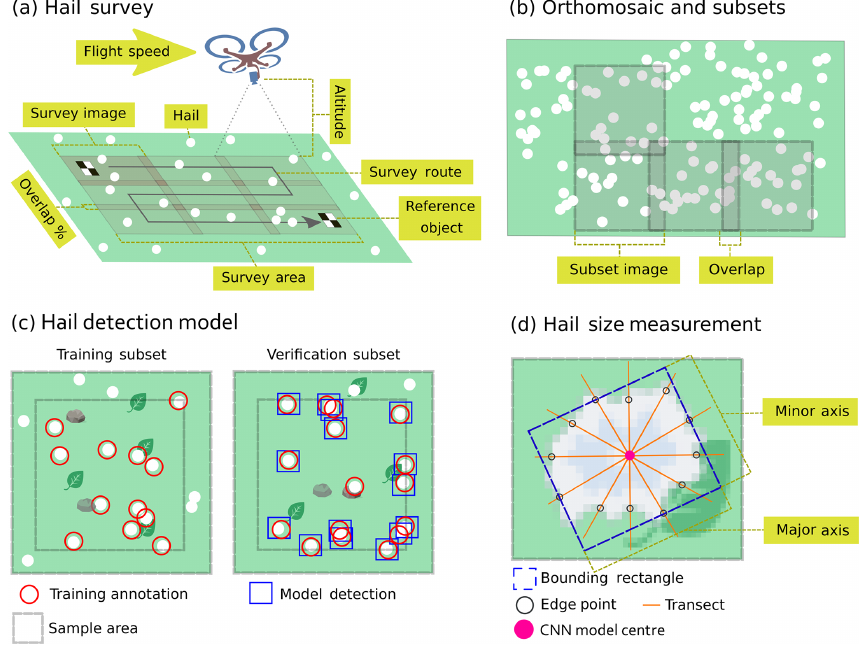
Figure 1. Workflow of (a) data collection, (b) tiling of orthomosaic, (c) hail detection using the Mask R-CNN technique and (d) hail size measurement using radial